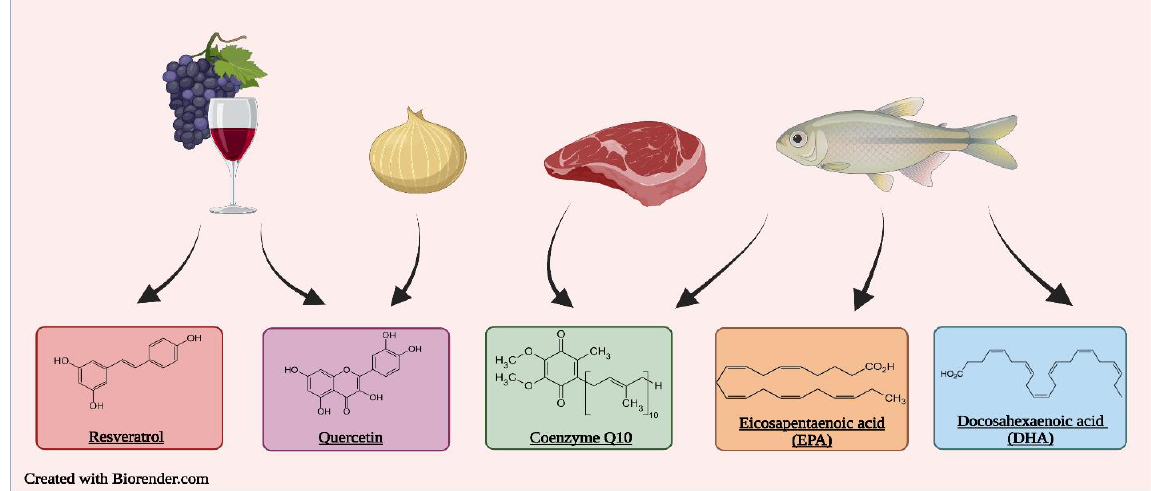
Figure 1. Most popular food sources of the bioactive compounds are resveratrol, quercetin, coenzyme Q10, EPA, DHA.